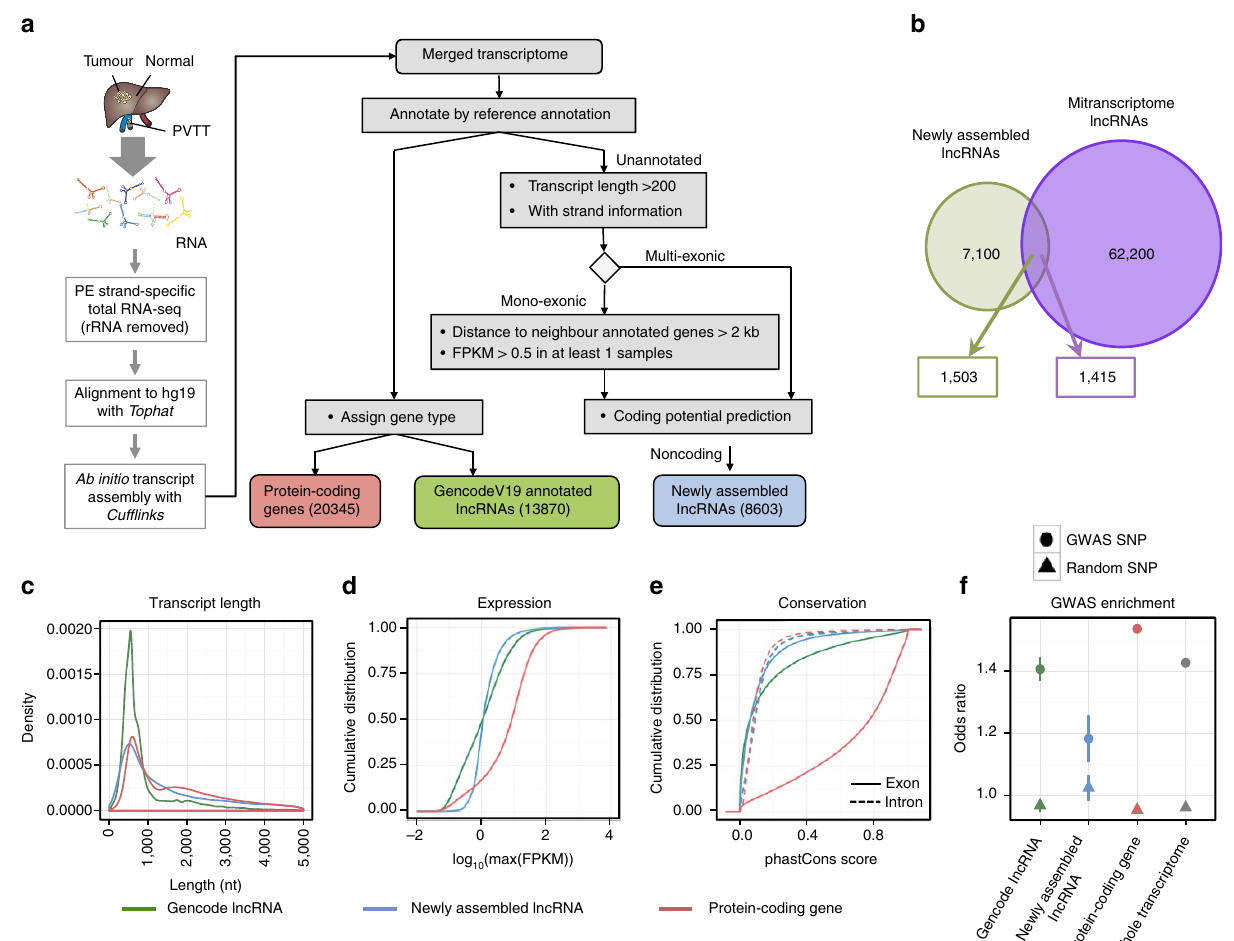
Figure 1 | Identification of candidate lncRNAs in 60 HCC samples. ( a ) Overview of the comprehensive experimental and computational scheme for the systematic identification of lncRNAs in samples from HCC patients. ( b ) Venn diagram showing the overlap between newly assembled lncRNAs and MiTranscriptome lncRNAs. Characterization of GENCODE lncRNAs, newly assembled lncRNAs and protein-coding genes: ( c ) transcript length distribution; ( d ) cumulative distribution curve of maximum gene expression level (RPKM); ( e ) conservation of exons and introns; ( f ) enrichment of GWAS SNPs (circle) over randomly selected SNPs